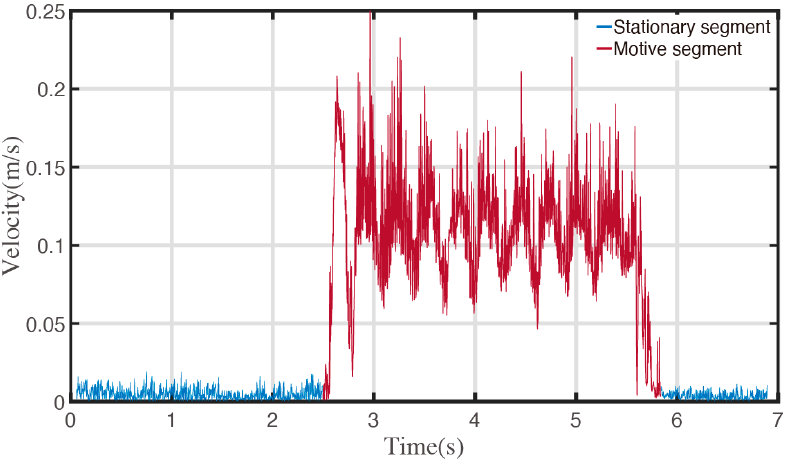
Figure 10. Stationary segment